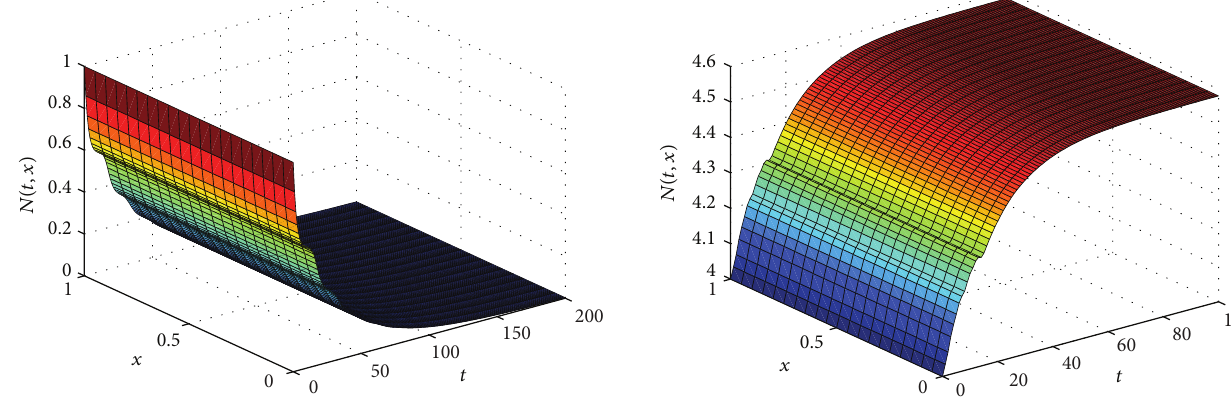
Figure 1: Parameters: 𝛿 = 0.4 , 𝑝 1 = 0.1 , 𝑝 2 = 0.15 , 𝑎 = 0.1 , 𝜏 1 = 12 , Figure 2: Parameters: 𝛿 = 0.1 , 𝑝 1 = 0.1 , 𝑝 2 = 0.15 , 𝑎 = 0.2 , 𝜏 1 = 12 ,